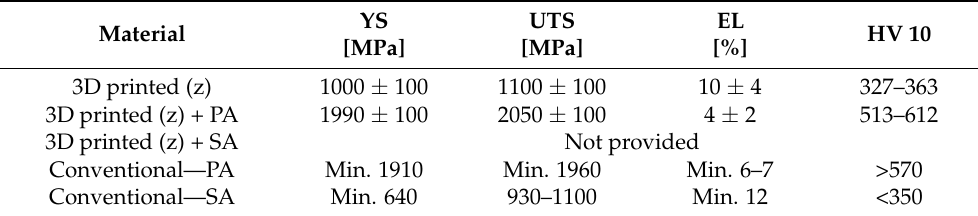
Table 4. Mechanical properties of steel 1.2709 according to datasheets, given for tensile testing according to ISO 6892-1:2009 (B) Annex D, proportional test pieces: diameter of neck area 5